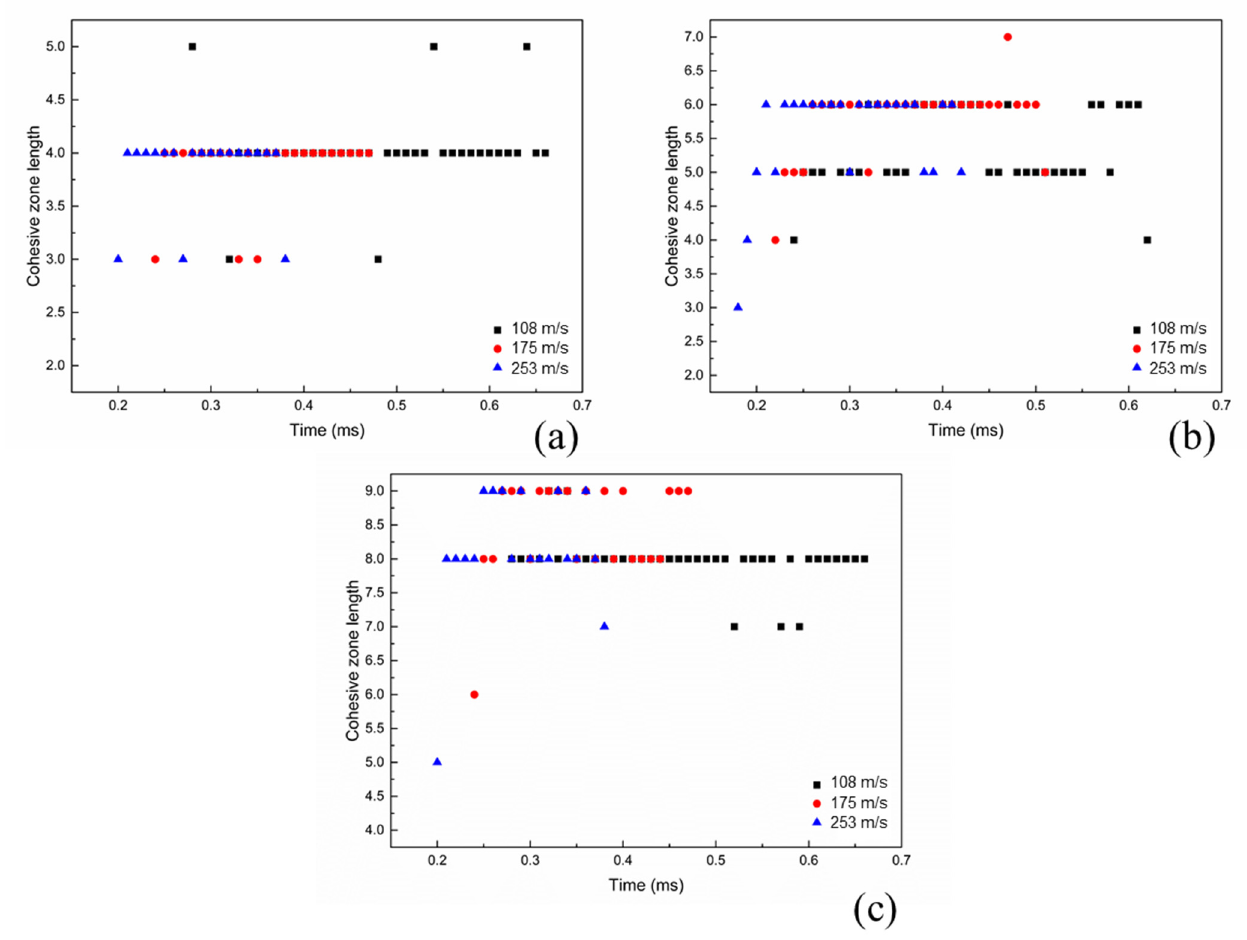
Figure 6. The relationship between cohesive zone length and time of ( a ) logarithmic model, ( b ) exponential model and ( c ) power model.